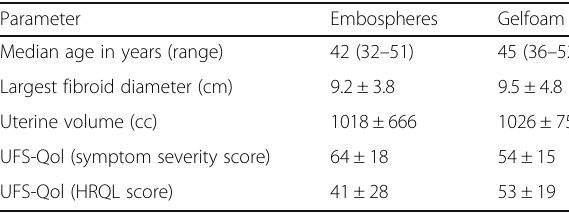
Table 2 Baseline clinical parameters for both